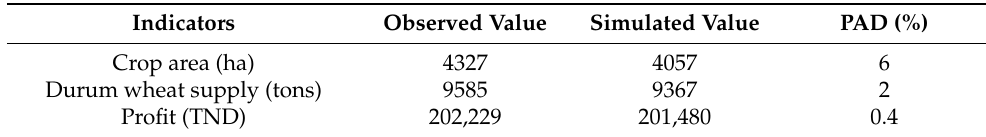
Table 4. Simulated regional level vs. observed